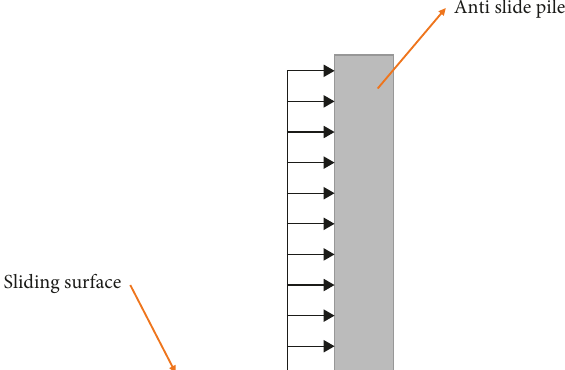
Figure 1: Rectangular distribution of landslide thrust.